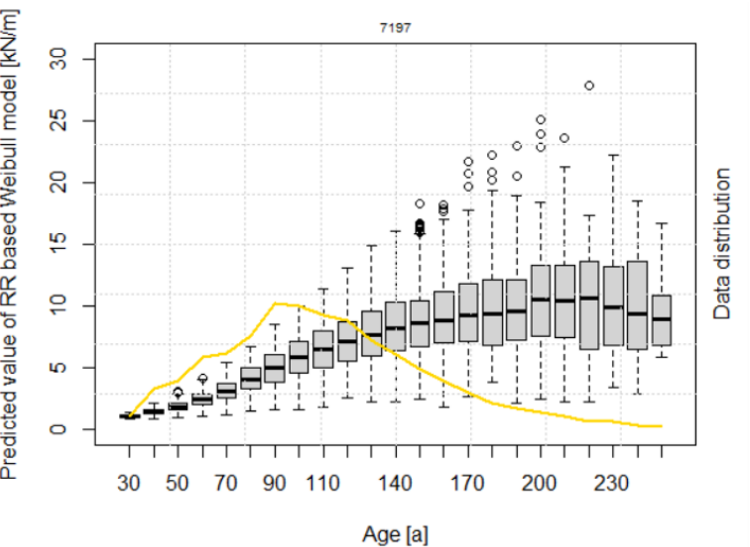
Figure 4. Root reinforcement dynamics over time, according to the model after Weibull. The data are presented in 10-year classes from 30 up to 250 years. The yellow line shows the distribution of data frequency in